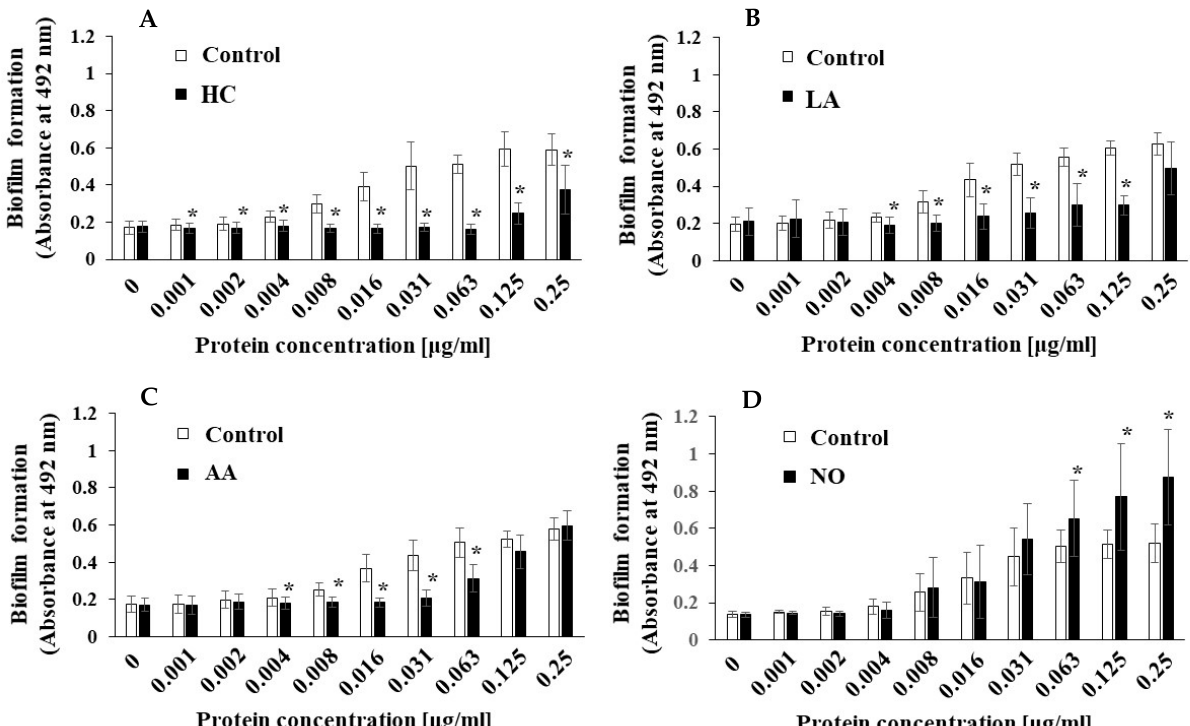
Figure 8. Effects of initial pH condition on the MVs-dependent biofilm formation in condition with raffinose. Biofilm formation of S. mutans UA159 gtfBC - was quantitatively assessed in TSB with 0.25% raffinose with various concentrations of MVs from S. mutans UA159 in initial pH 6.0 condition prepared with HC ( A ), LA ( B ), and AA ( C ), and the initial pH 8.0 condition prepared with NO ( D ). The data indicate the mean ± SD of three independent experiments. The asterisks indicate a significant difference between the groups (*: p < 0.05, MVs in control condition vs. MVs in initial pH 6.0 and 8.0 conditions).